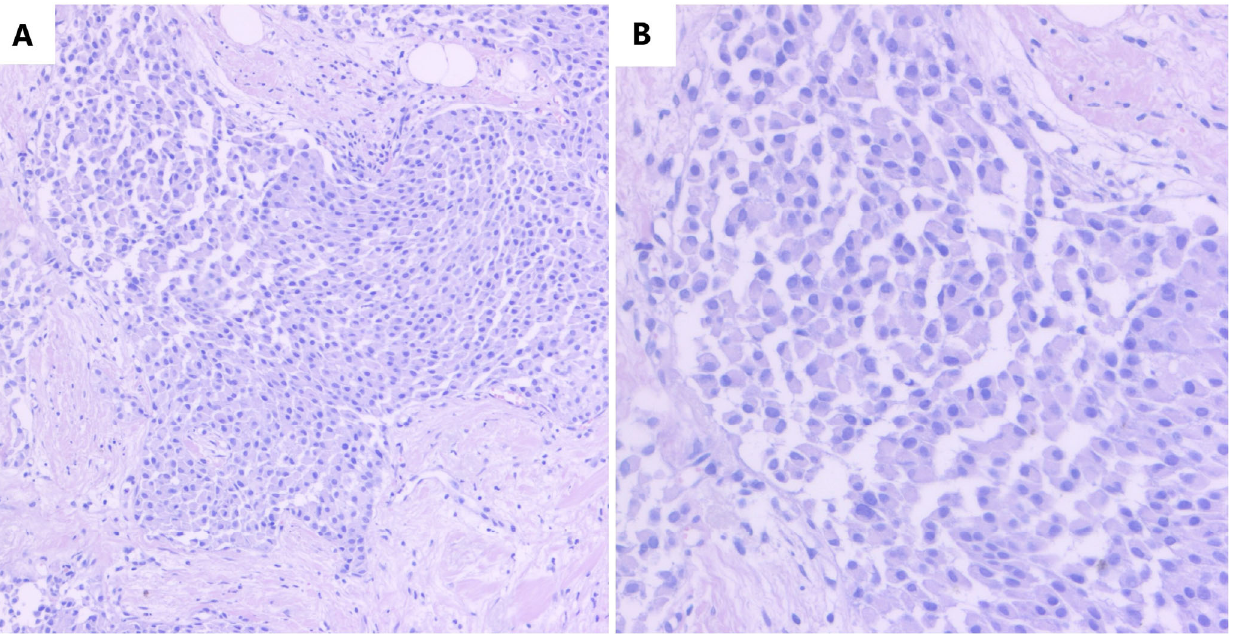
Figure 1. ( A ) Core tissue examination revealing a tumor proliferation with an infiltrative aspect, consisting of plasmacytoid cells arranged in solid nests (HE, ob. 10×); ( B ) Details of the described area (HE, ob. 20×).